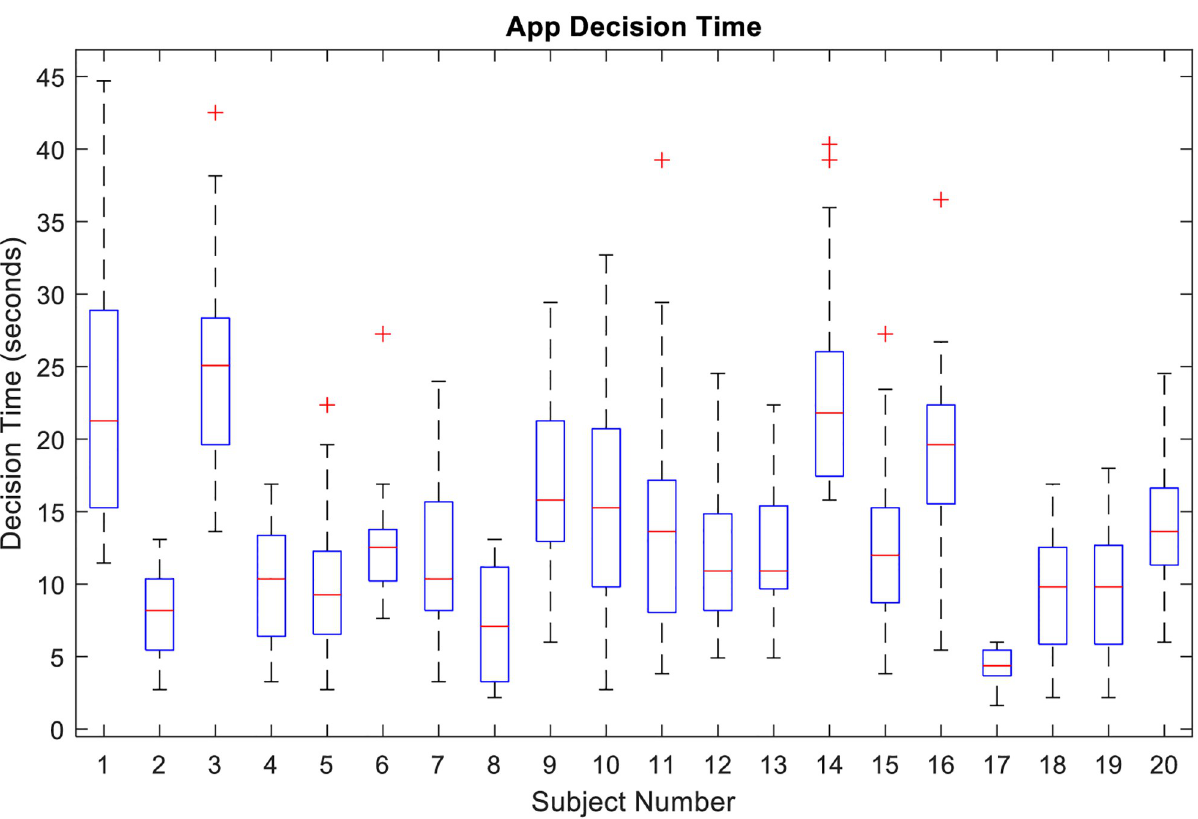
Fig 2. Distribution of subject wise decision time for all 25 apps. Each column shows the boxplot of the decision (response) time in seconds for the corresponding participant. The central red line indicates the median, the top and bottom edge of the box corresponds to the 75 th and 25 th percentile respectively and the outliers are indicated by the red ‘ þ ’